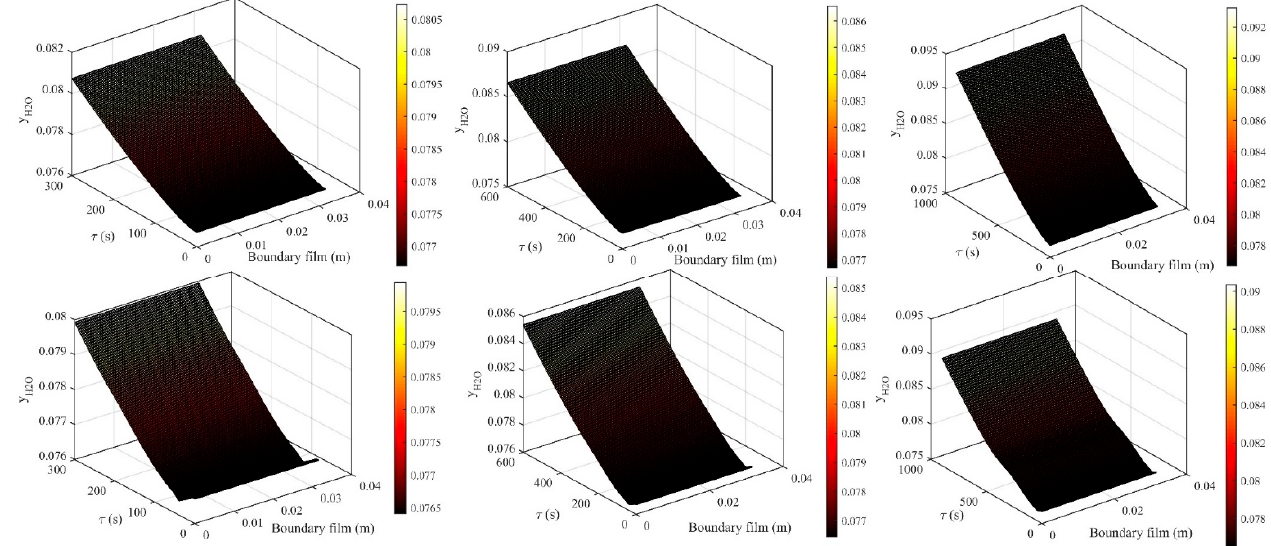
Figure 14. The distribution of mass fraction across the gas film at different torrefaction period ( a ) 5 min, ( b ) 10 min, ( c ) 15 min, y H2O (quasi-static); ( d ) 5 min, ( e )10 min, ( f ) 15 min, y H2O (dynamic).